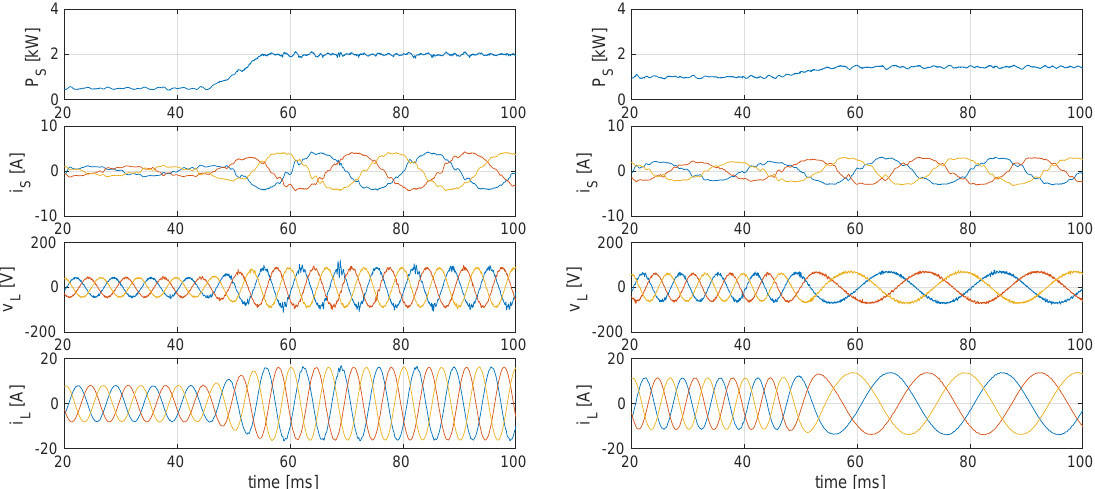
Figure 13. Simulation results of the electrical quantities at the source ( P S , i S ), and at the load ( v L , i L ), during transients of desired output voltage. In the ( left panel ) the desired amplitude was ramped from 50 V to 100 V from time 45 ms to time 55 ms, so that the power ramps from about 500 W to about 2 kW. In the ( right panel ) the desired frequency was swept from 150 Hz to 50 Hz during the same time span, while the voltage was held constant at 70.7 V. Power starts at about 1 kW and then rises due to lower reactance of